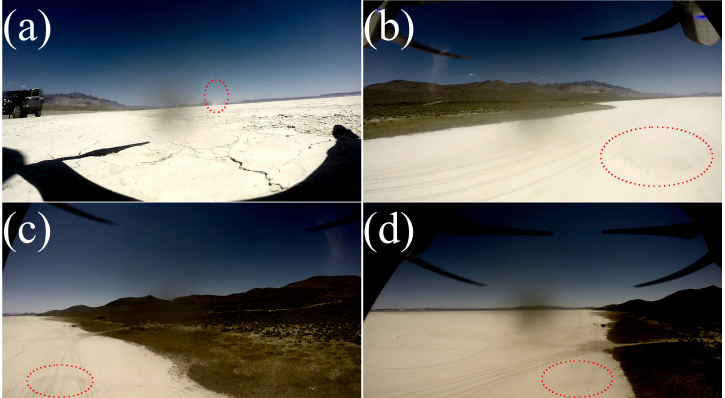
Figure 3. Stills from the video collected onboard the drone during Flight 0. ( a ) just prior to launch (which occurred at approximately timestamp 0:31), with the first target dust devil highlighted by a red, dashed circle; ( b ) the dust skirt of the first target dust devil just prior to the first encounter, which occurred approximately 12 s after launch (at timestamp 0:43); ( c ) the dust skirt of the first dust devil just prior to the second encounter, which occurred approximately 23 s after launch (at timestamp 0:54); ( d ) the dust skirt of the second dust devil just prior to the first and only encounter, which occurred approximately 36 s after launch (at timestamp